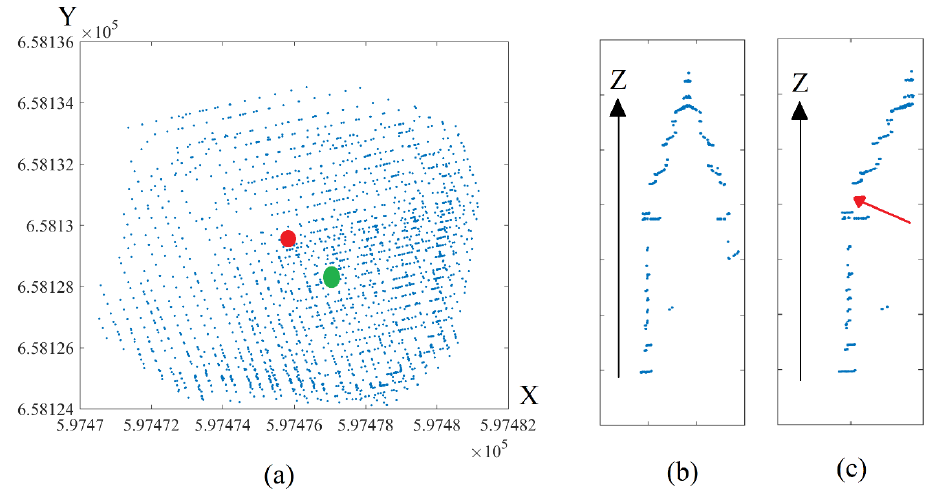
Figure 5. ( a ) Projection of a 3D tower point cloud on a horizontal plane passing through the coordinate origin; the red circle is the gravity center calculated based on extreme coordinate values; the green circle is the gravity center calculated based on static moments. ( b ) Vertical cross-section passing through the gravity center. ( c ) Semi-vertical cross-section.